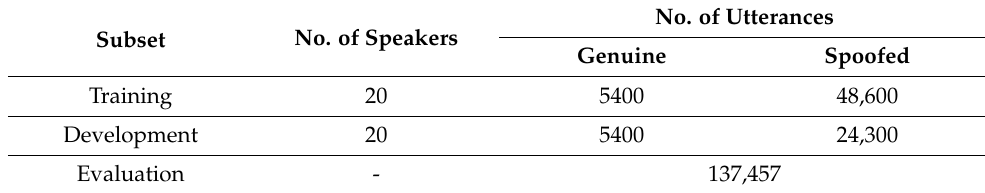
Table 4. ASVspoof 2019 replay spoofing